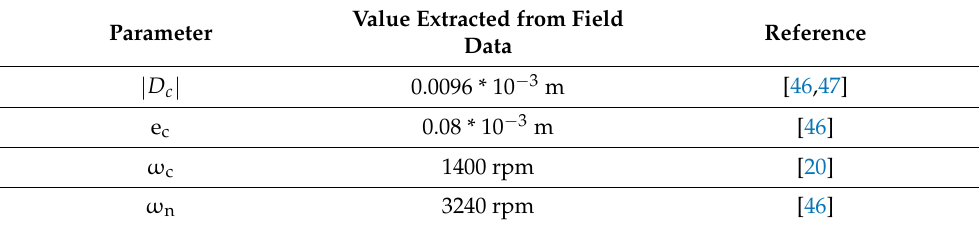
Table 2. Field data on a case study conducted with respect to | D c | .